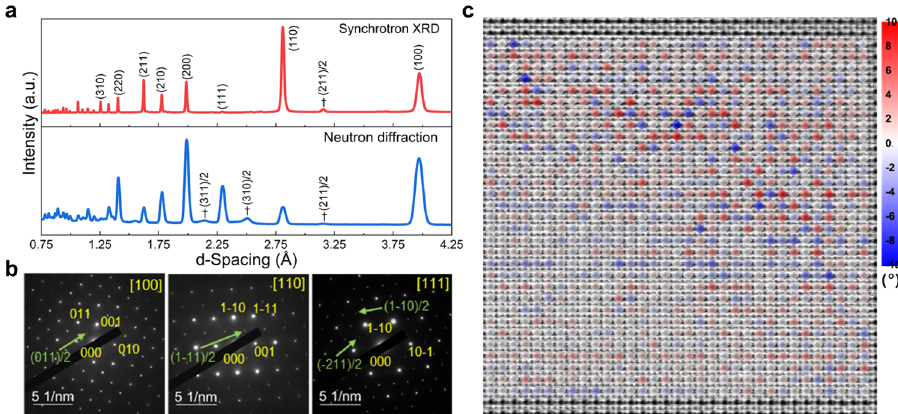
Fig. 3 Disordered oxygen octahedron tilt in KNN-H ceramic. a Synchrotron XRD and neutron diffraction. “†” represents the positions of the superlattice peaks. b SAED patterns along [100] c , [110] c , and [111] c . c Atomic-resolution ABF STEM image along [100] c as well as the calculated oxygen octahedral tilt along y axis, blue and red indicate clockwise and anticlockwise tilt, respectively.